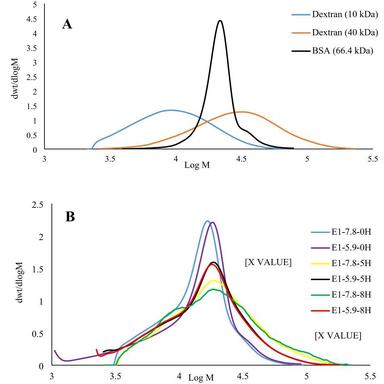
Molecular weight distributions of (A) dextran and BSA reactants; (B) E1 samples (1:1 wt. ratio of 10 kDa dextran and BSA) after lyophilization at pH 5.9 or 7.8 at various reaction times (0, 5 or 8 h). See Table 1 for further details.